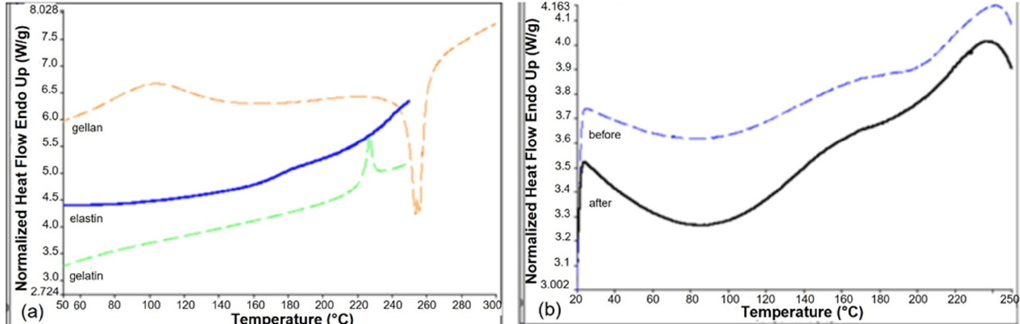
Figure 5. DSC thermograms of pure components ( a ) and of GGE tubular scaffolds, before and after cross-linking ( b ).